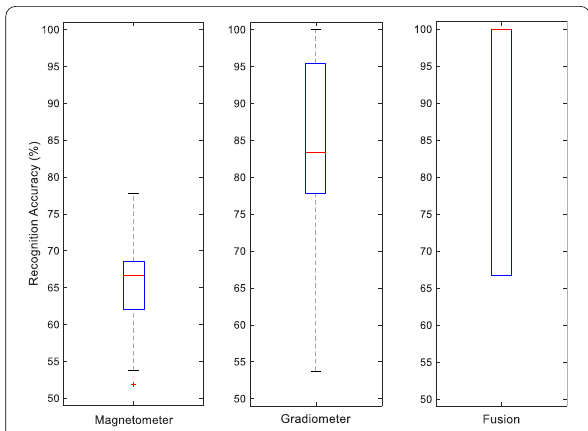
Fig. 5 Comparison between two modalities and the effectiveness of their score‑level fusions: Megn mean accuracy (3‑NN) 65.43%, SD 0.0514; Grad mean accuracy (QBNC) 85.93%, SD 0.1089; Fusion mean accuracy: 88.33%, SD